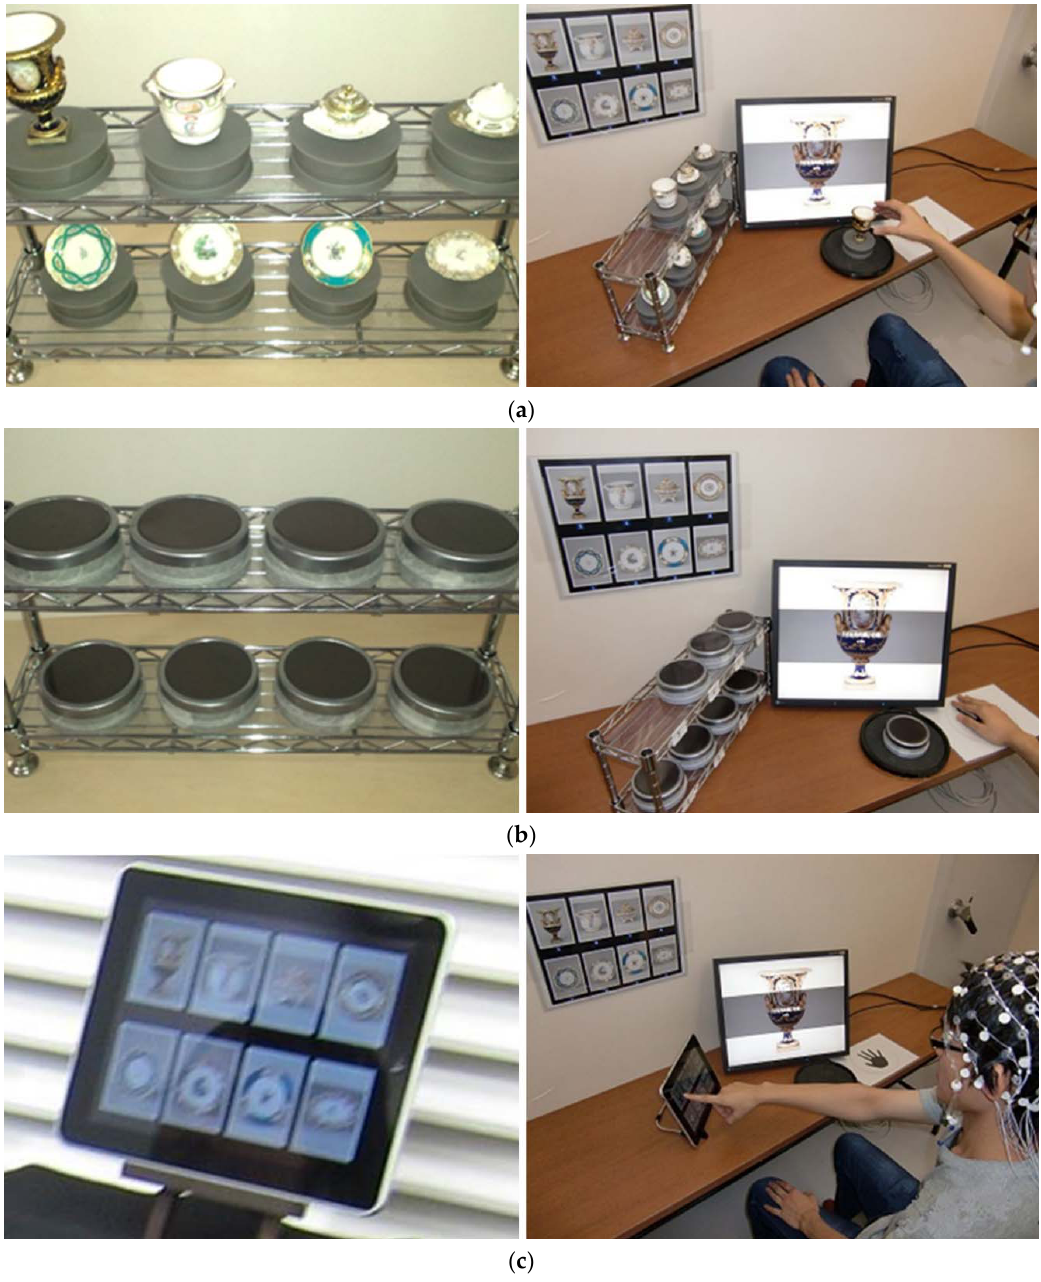
Figure 3. Settings of different conditions in Experiment 2: ( a ) TUI/OBJECT condition; ( b ) TUI/CAN condition and ACTION condition (in the ACTION condition, no porcelain picture was displayed on the screen); ( c ) GUI condition.